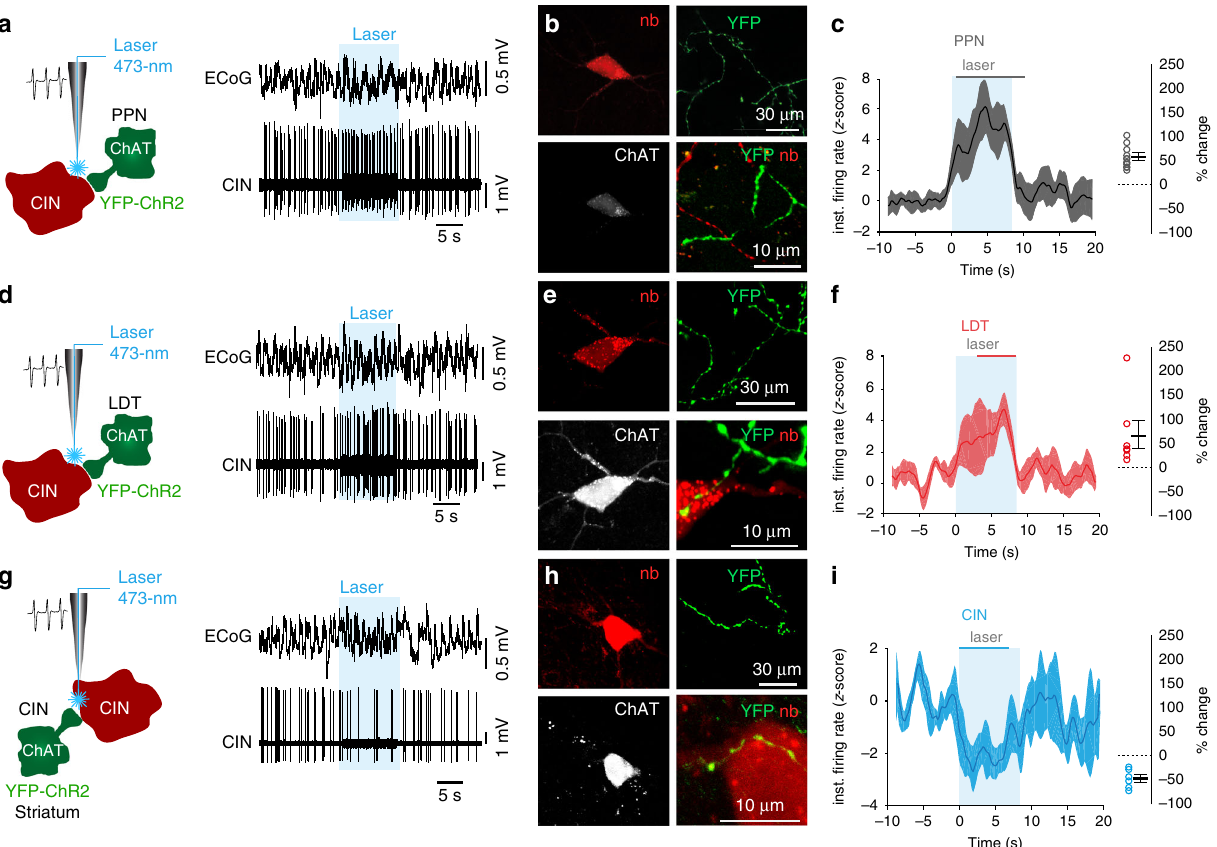
Fig. 3 Cholinergic modulation of cholinergic interneurons (CINs). Individual CINs activity was recorded in vivo during optogenetic activation (8 s, 10 Hz, 50-ms pulses) of cholinergic axons originating in the PPN ( a – c ; n = 19 neurons), LDT ( d – f ; n = 13 neurons) or from local CINs ( g – i ; n = 10 neurons). CINs were subsequently labeled with neurobiotin. Only neurobiotin-labeled CINs that were immunopositive for ChAT and surrounded by YFP-positive axons were used for further analyses b, e, h . The normalized instantaneous fi ring rate of all CINs that responded to laser stimulation of PPN c and LDT f show similar increase in fi ring rate shortly after stimulation, whereas non-transduced CINs (YFP/ChR2-negative; i ) were strongly inhibited during stimulation (color lines in the top represent the time points during which the responses were signi fi cantly different from the baseline; cluster-based permutation test, P < 0.05). Similar magnitudes of change were elicited by stimulation of PPN and LDT cholinergic axons (% change in fi ring rates: PPN, 62.05 ± 7.4; LDT, 52.54± 16.2; CINs, − 50.17 ± 5.2; one-way ANOVA F (2,41) = 28.19, P = 0.00001; Bonferroni post hoc analysis: CIN vs. LDT P = 0.0001, CIN vs. PPN P = 0.0001, LDT vs. PPN P = 1.0). Individual data points and mean ± SEM are shown. * P < 0.05. All experiments have been replicated at least three